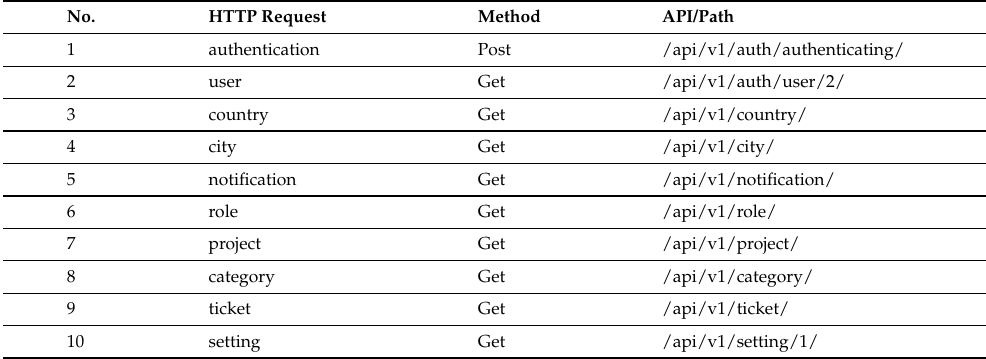
Table 3. Pages requested by the TaqTak application.